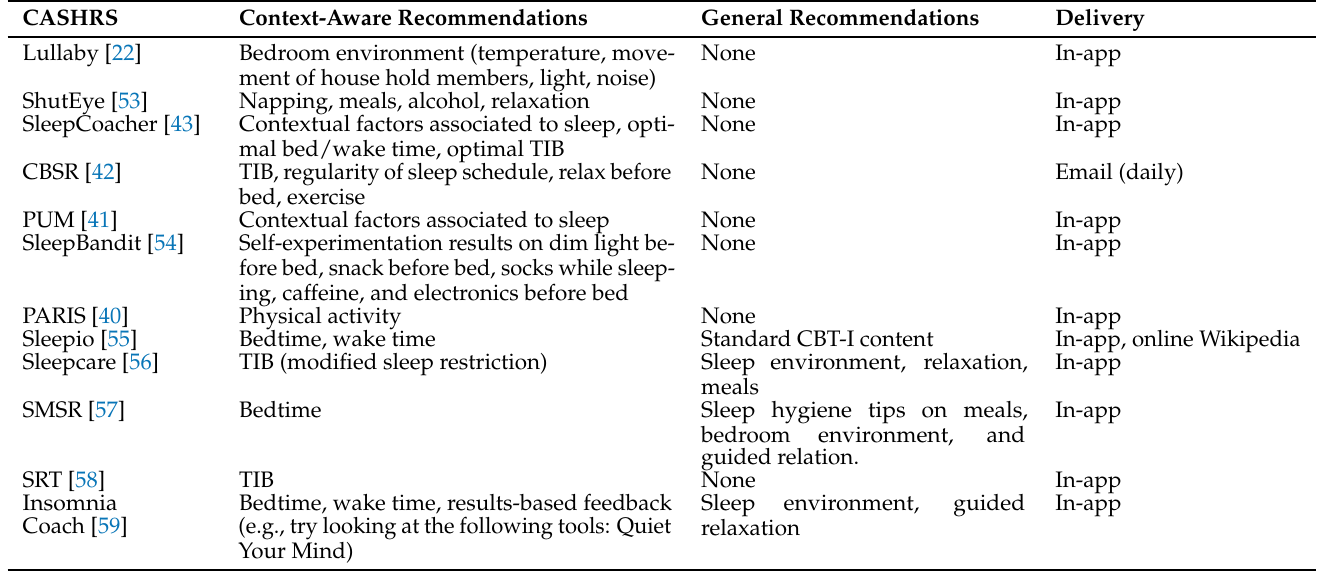
Table 4. Recommendation content and